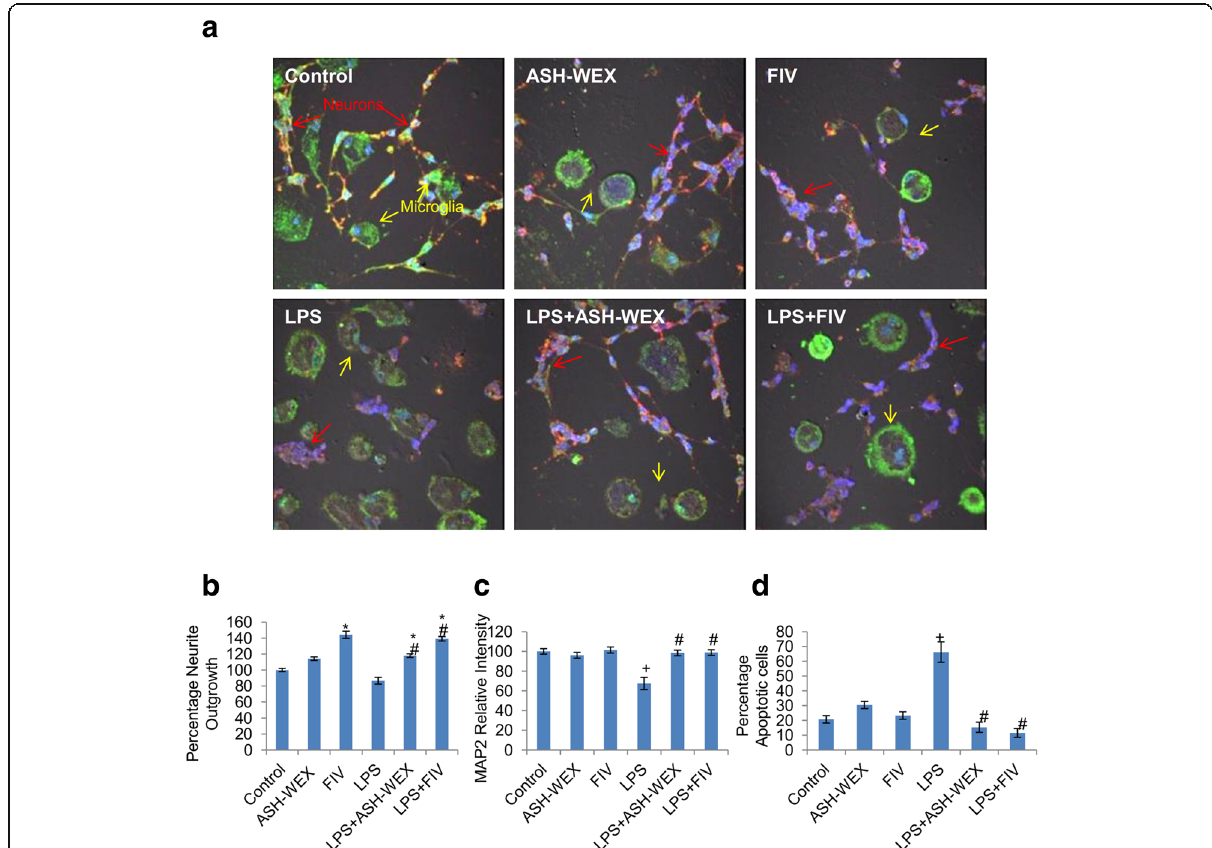
Fig. 7 ASH-WEX and FIV also inhibit inflammatory neurodegeneration in microglial-neuronal co-culture ( A ) Representative Confocal micrographs of MAP2 (red) and Iba-1 (green) co-immunostaining in cerebellar neurons co-cultured with microglia pretreated with 0.2% ASH-WEX and 10 μ g/ mL FIV for 24 h, then challenged with 100 ng/mL LPS for 36 h. Nuclei were stained with DAPI. Red arrows denote cerebellar neurons and yellow arrows denote microglial cells. ( b , c , d ) Histograms presenting the data of percentage neurite length, relative optical intensity of MAP2 and percentage of apoptotic cells (Mean ± SEM) among the different treatment groups calculated from three independent experiments. * p ≤ 0.05 untreated control versus ASH-WEX alone, FIV alone, LPS + ASH-WEX and LPS + FIV-treated groups. + p ≤ 0.05 control versus LPS-treated group. # p ≤ 0.05 LPS- versus LPS + ASH-WEX- and LPS + FIV-treated groups (one-way ANOVA with Holm-Sidak post hoc test). Images were captured